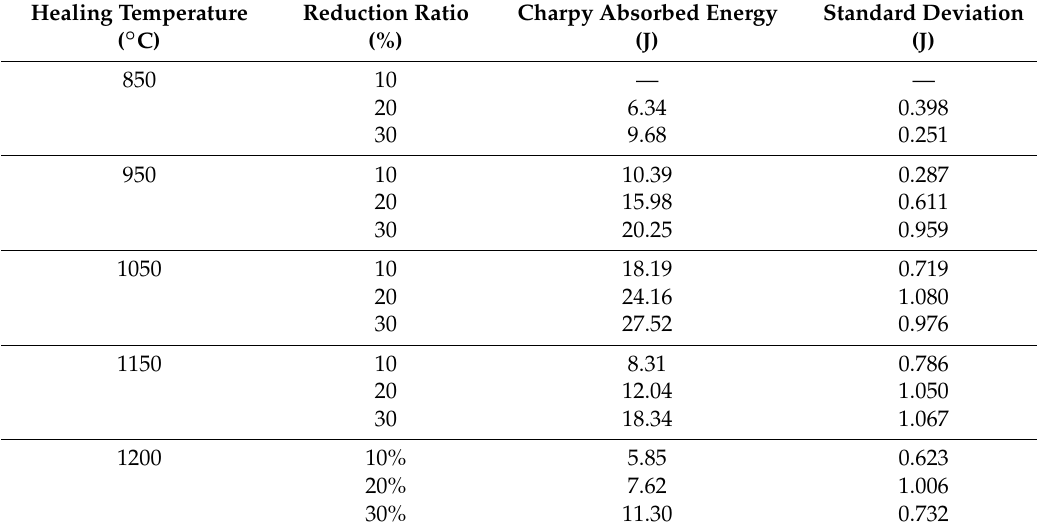
Table 1. The room-temperature impact properties of crack healing zones under different reduction ratios and healing